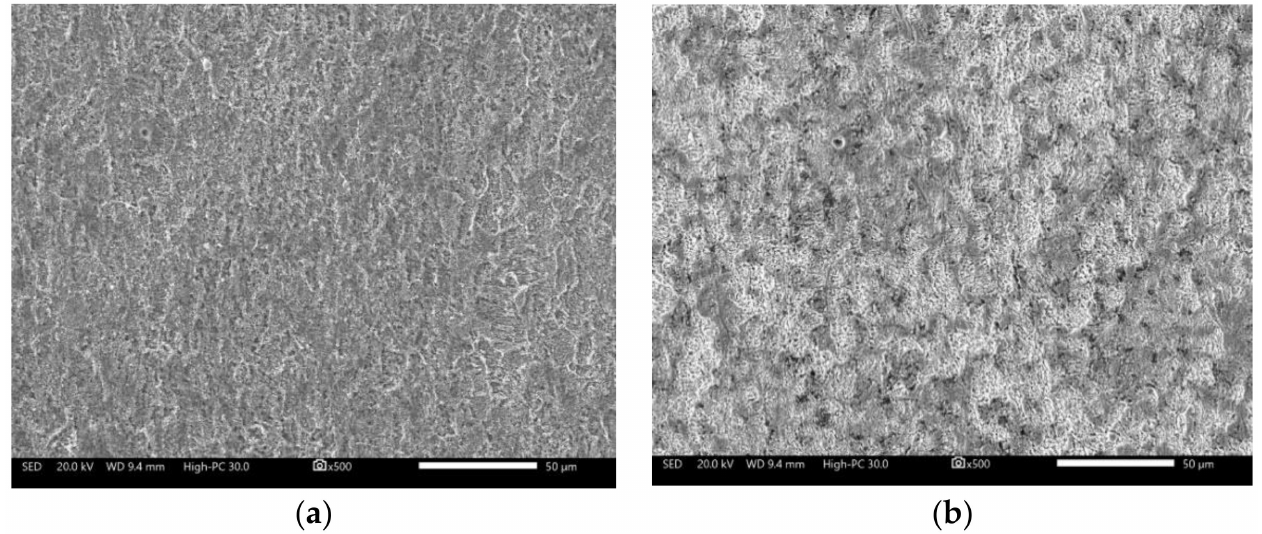
Figure 8. The morphological aspect of 1018 carbon steel after corrosion test in CO 2 -saturated brine solution after 50 h: ( a ) corrosion products surface; ( b ) clean